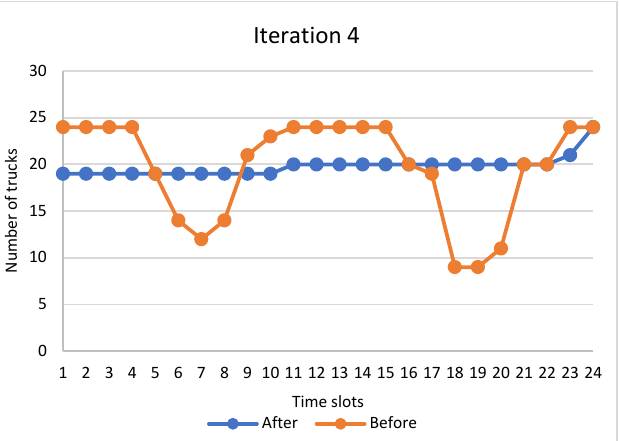
Figure 10. The workload before and after applying balancing constraint on iteration 4.